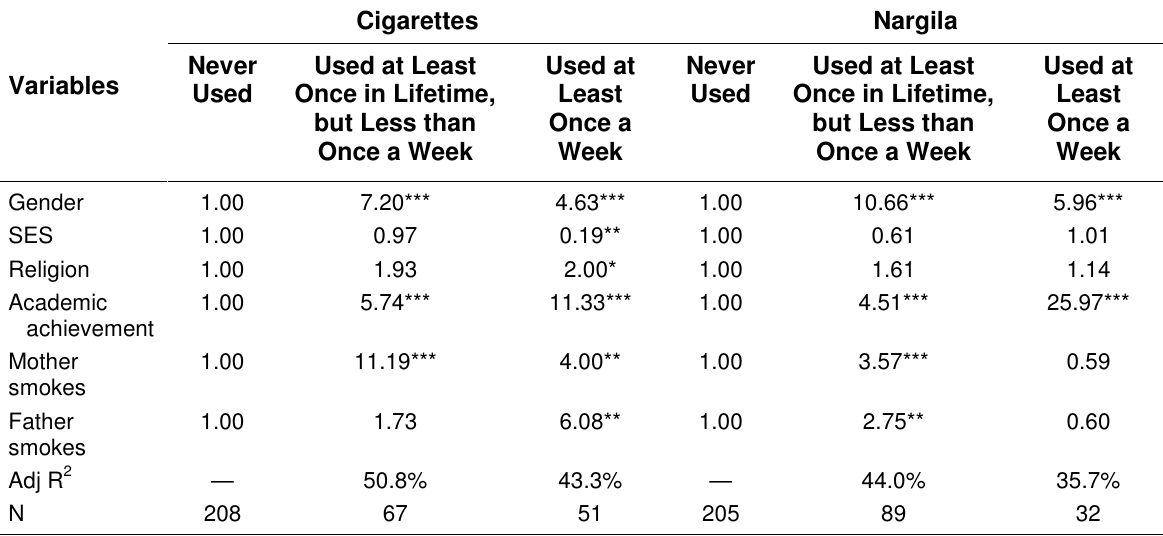
Nargila Cigarettes Used at